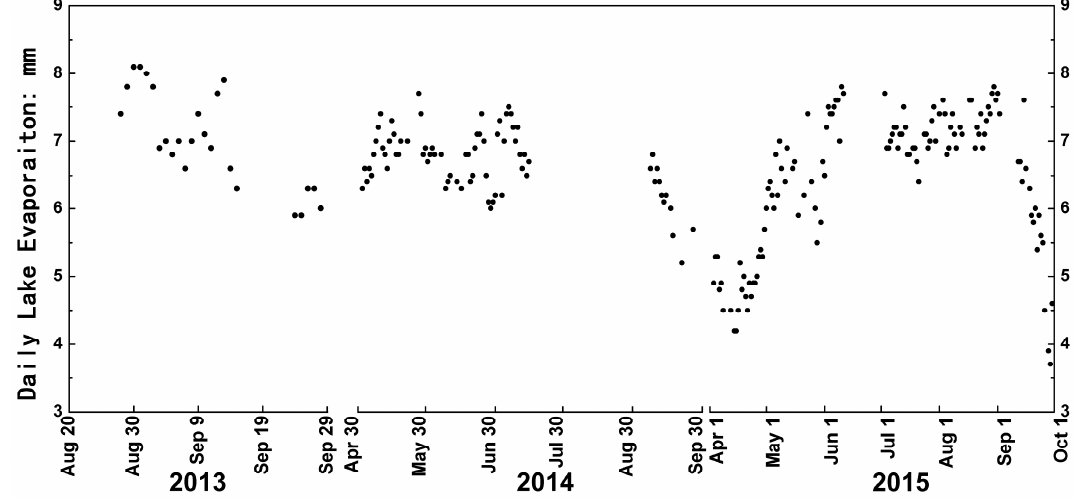
Figure 3. Time series of measured daily evaporation of EJL.